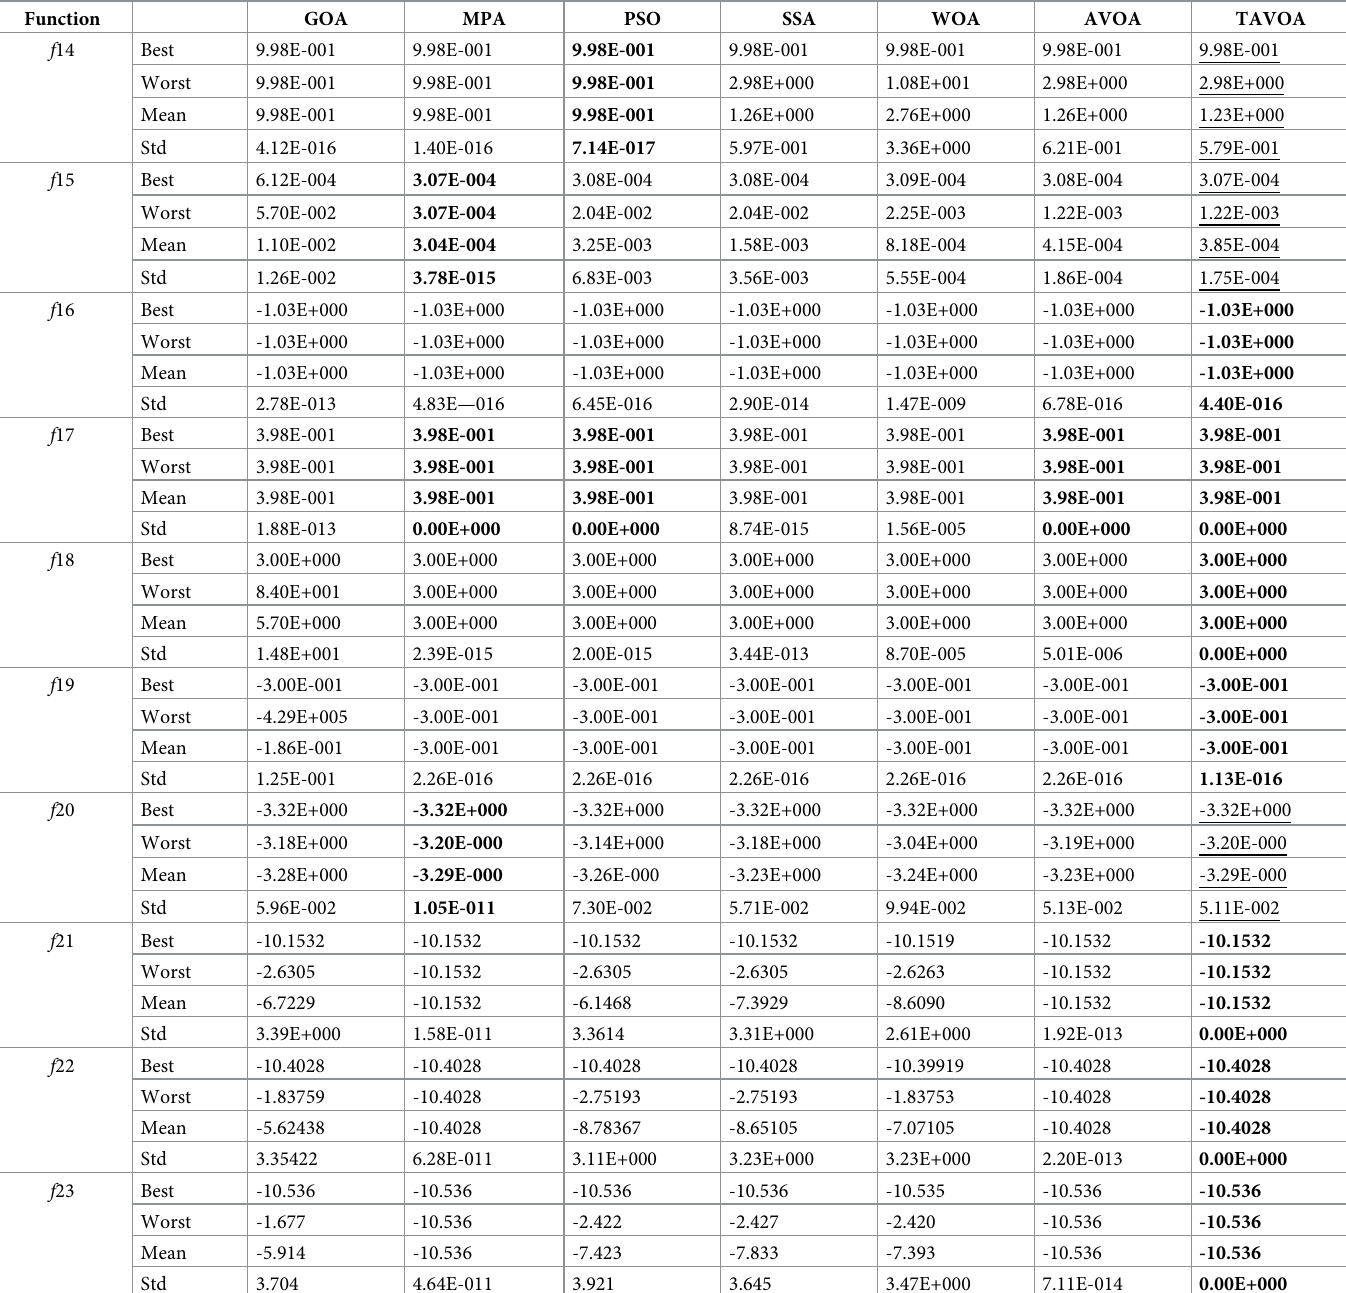
Table 5. Experimental results of basic fixed-dimension multi-modal benchmark functions ( f 14 − f 23).